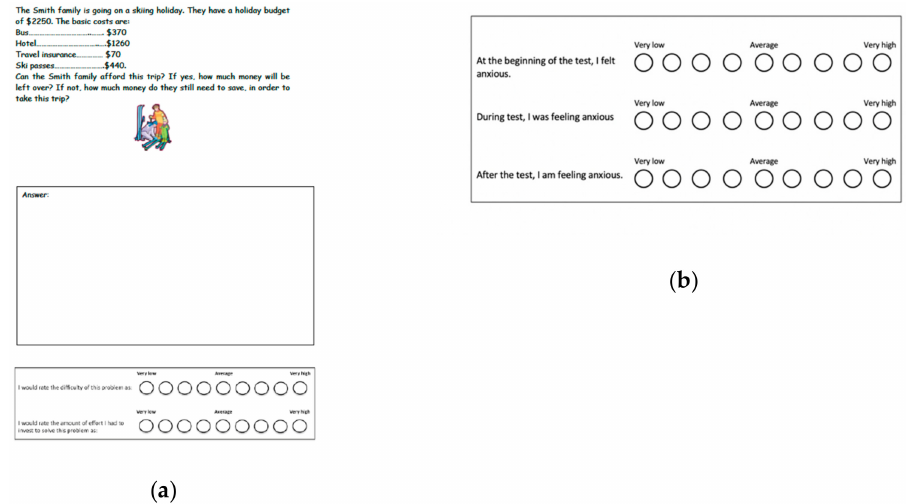
Figure 1. ( a ) Example of math test question and ratings for task di ffi culty and mental e ff ort. ( b ) Ratings for anxiety at the beginning, during, and end of math test.